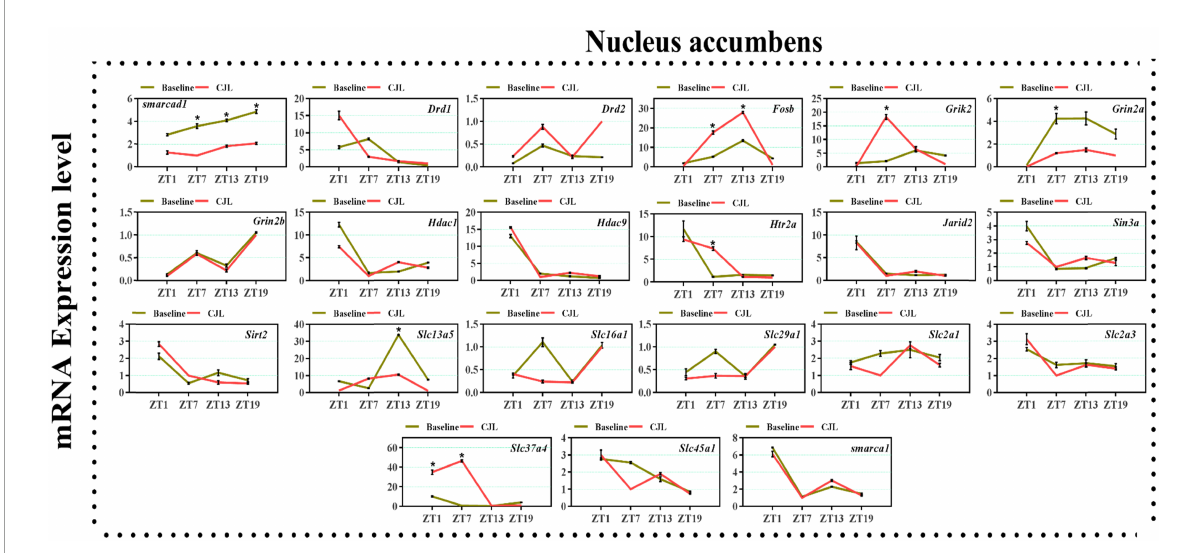
FIGURE2 Chronic jetlag (CJL) altered mRNA levels of genes associated with psychiatric disorders in the NAc. This figure shows mRNA levels in NAc extracts from baseline and CJL treated animals ( n = 3 per group), as assayed by three independent qPCR assays, at four different time points (ZT1, ZT7, ZT13, and ZT19). Expression levels in CJL treated mice were normalized to selected expression levels in baseline mice at specific ZT. Results are expressed as mean ± SEM. * P < 0.01, two-way ANOVA.